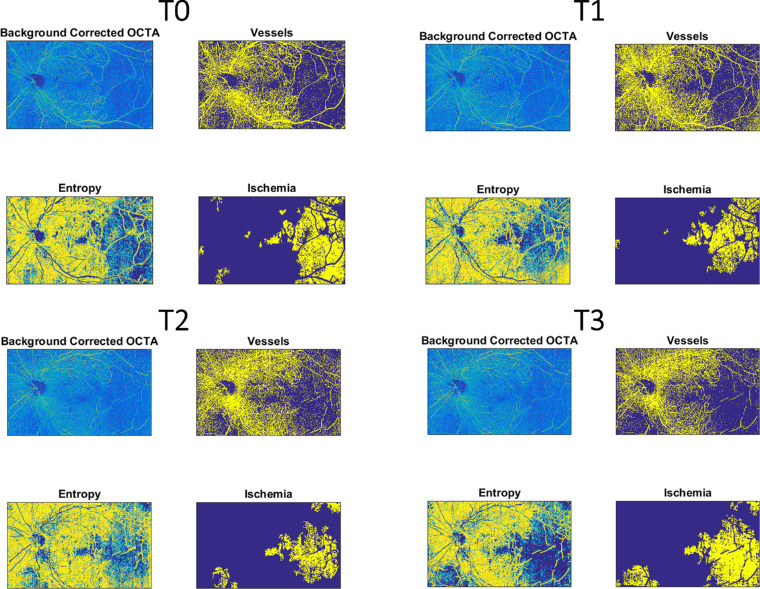
Retinal nonperfusion retinal capillary areas modification of SCP in a single patient after IDI during follow-up.